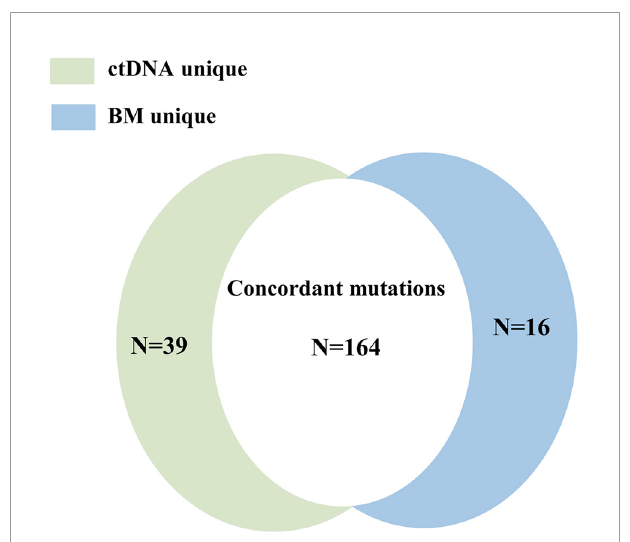
FIGURE 3 | The correlation of the number of mutations in a separate patient detected in BM and ctDNA.